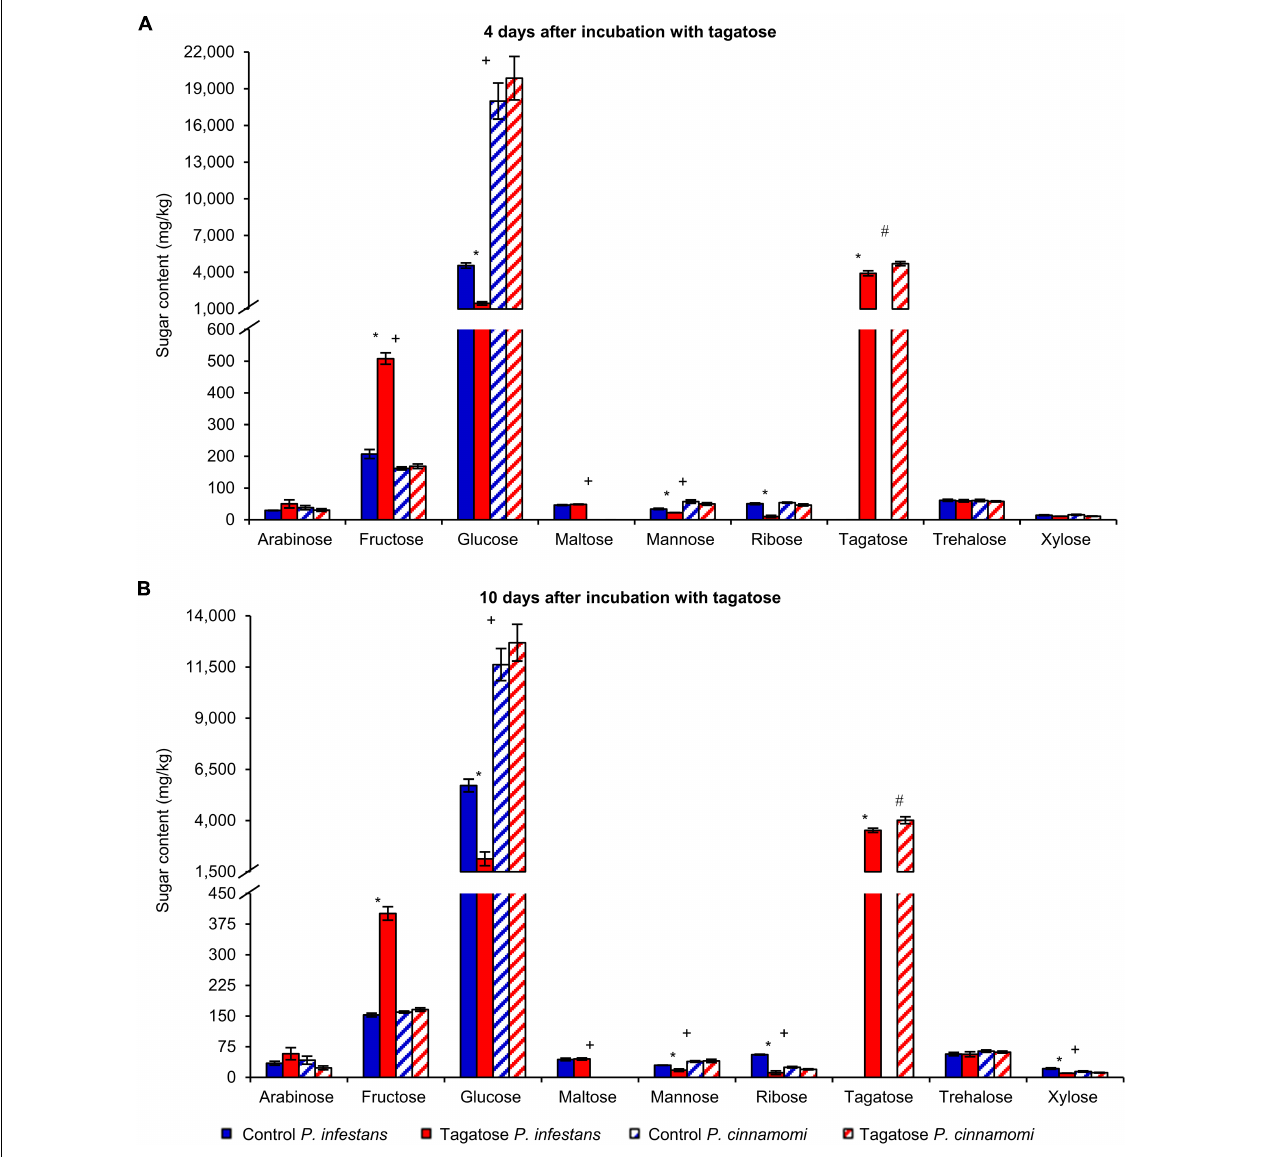
FIGURE 1 | Effect of tagatose on Phytophthora spp. sugar content. Phytophthora infestans (solid bars) and P. cinnamomi (stripped bars) sugar content was quantified at 4 (A) and 10 (B) days after incubation (DAI) on pea agar medium in the absence (control, blue) and presence of tagatose (red). The two-way analysis of variance (two-way ANOVA) showed no significant differences between the two experimental repetitions ( P > 0.05, three replicates per experiment) and data from the two experiments were pooled. Mean and standard error values of six replicates from the two experiments are presented for each treatment. For each sugar and time point, significant differences between tagatose-incubated samples and control samples are marked with an asterisk (*) for P. infestans and a hashtag (#) for P. cinnamomi , according to the Student’s t -test ( P ≤ 0.05). Significant differences between P. infestans control and P. cinnamomi control for each sugar are marked with a plus sign (+), according to the Student’s t -test ( P ≤ 0.05). Isomaltose, lactose, melibiose and rhamnose were not detected and omitted from the